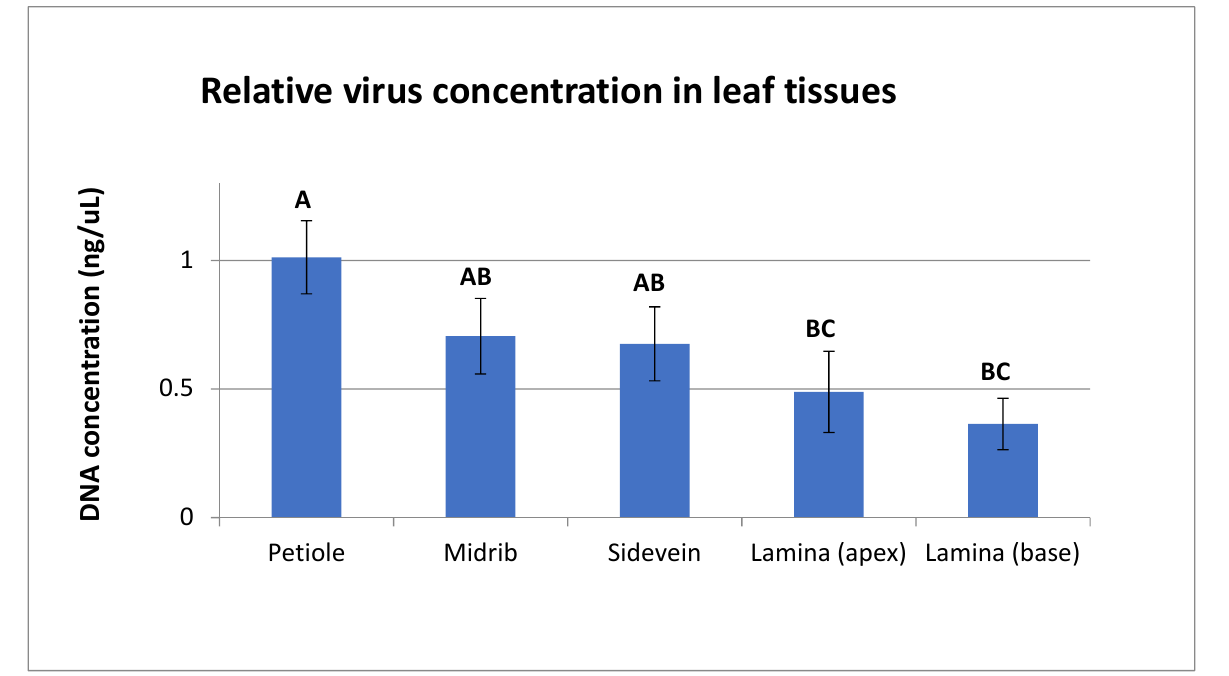
Figure 6. Mean DNA concentration of Cacao mild mosaic virus (CaMMV) in different cacao ( Theobroma cacao L.) leaf tissue types following amplification of 0.8 ng DNA extract with species-specific primers Mia1396F/Mia1667R. Columns with same letters above the bars are not significantly different ( p ≤ 0.05).